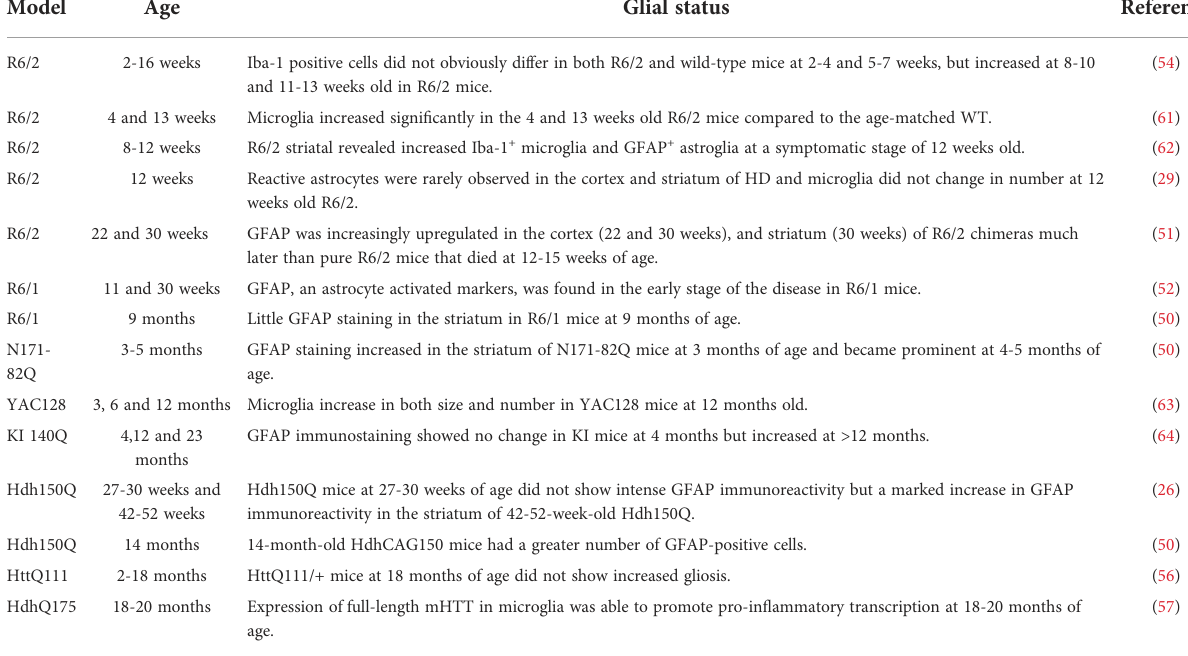
TABLE 1 Changes in glial cells in different HD mouse models at multiple